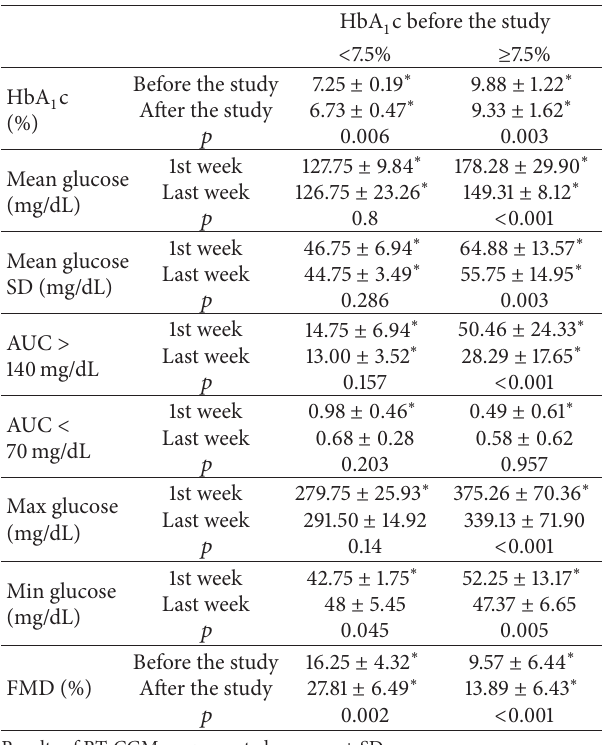
Table 3: Glucose variability depending on the initial HbA1c